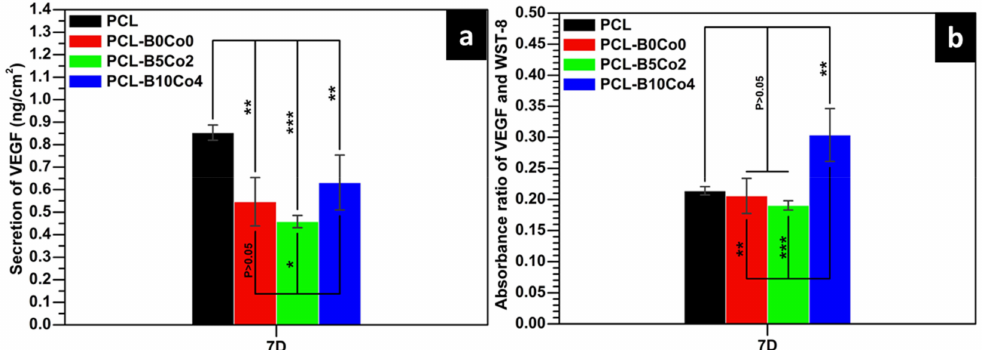
Figure 7. ( a ) Vascular endothelial growth factor (VEGF) secretion from ST2 cells directly cultured on PCL-BCo.BGNs mats for 7 days, ( b ) absorbance ratio of VEGF and WST-8 (0.01 < *P < 0.05, 0.001 < **P < 0.01, ***P < 0.001, mean ± SD, N = 3). Table 4. The concentrations of Si, B and Co released by PCL-BCo.BGNs mats after a 7-day cell cultivation period, measured with inductively coupled plasma-mass spectrometry (ICP-MS) (mean ± SD, N = 9).